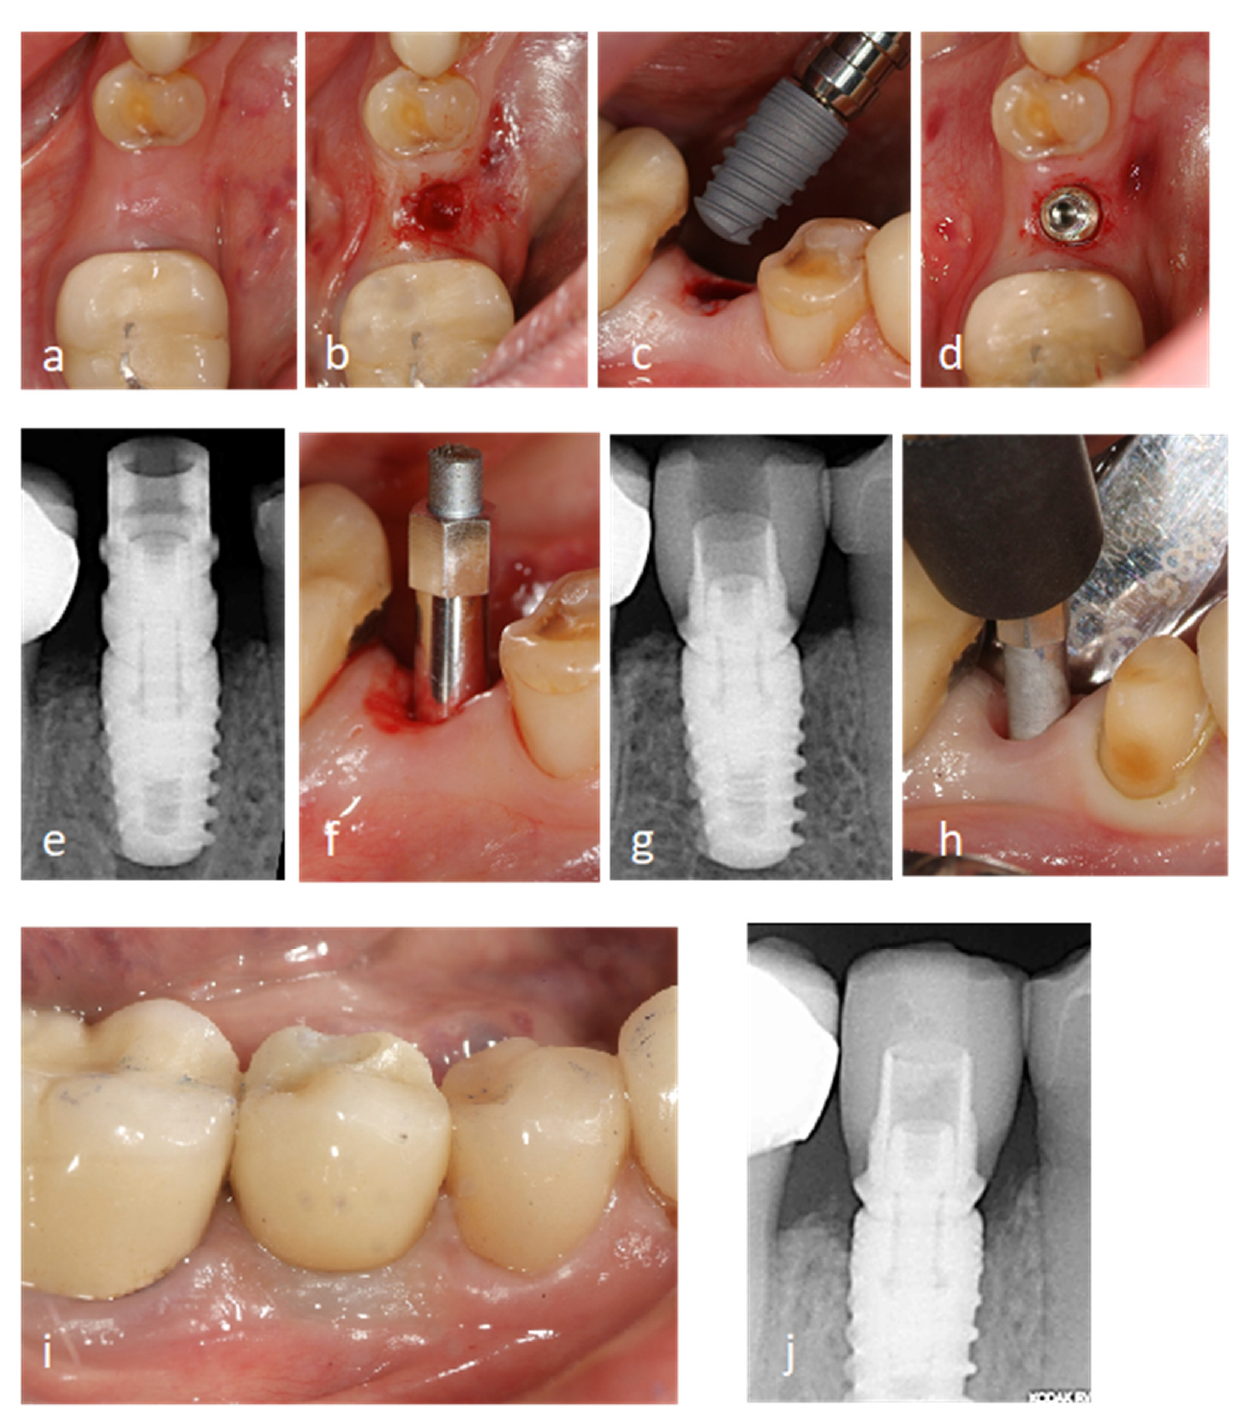
Figure 1. Clinical photographs and X-rays belonging to the short implants patient group (7 and 8.5 mm). Photographs taken during the surgery procedure of a 7 mm implant being placed ( a – d ), standardized periapical X-ray and implant stability quotient (ISQ) value measurement immediately after the implant placement ( e , f ), standardized periapical X-ray and ISQ value measurement day the definite prosthesis was loaded ( g , h ), Clinical photograph and standardized periapical X-ray 12 months follow-up ( i , j